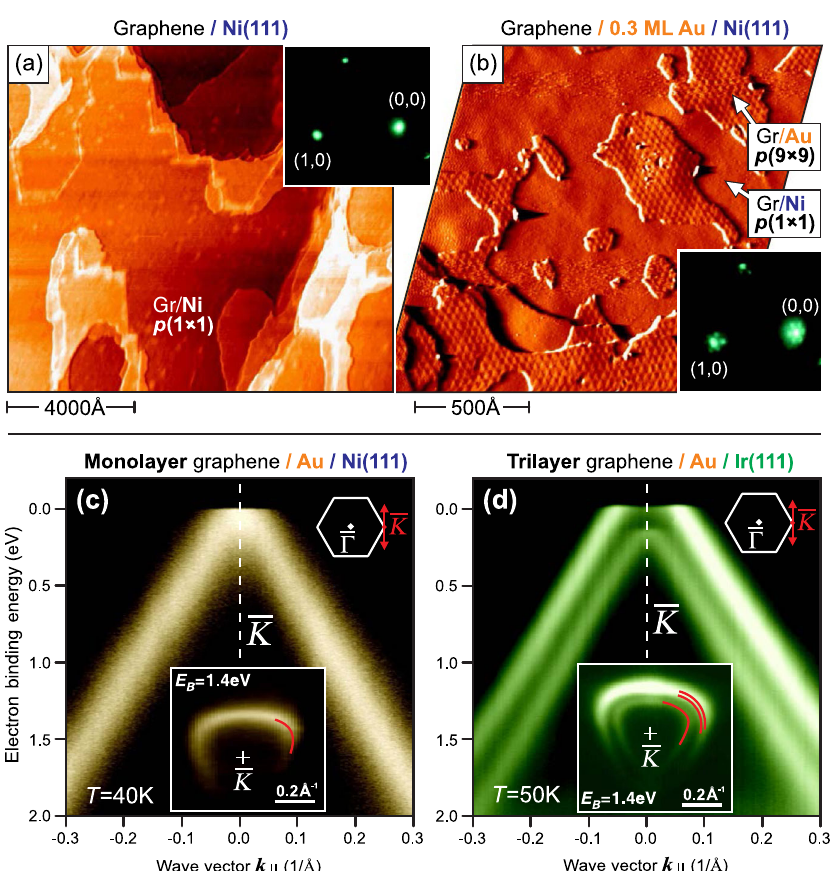
FIG. 5. Absence of graphene superstructure and multilayer formation. (a) Large-scale STM characterization of graphene on Ni(111) showing no moire´ superstructure due to lattice mismatch. (b) The intermediate-scale STM image of graphene on Ni(111) partially intercalated with Au (image contrast is enhanced) reveals a p ð 9 (cid:2) 9 Þ moire´ above Au islands but no moire´ pattern in the graphene on Ni areas. The insets represent LEED images ( E ¼ 40 eV ). (c) The electronic structure of graphene decoupled from Ni(111) by intercalation of Au reveals only one Dirac cone, which means that graphene is a monolayer. (d) Control sample [graphene trilayer on Ir(111)] shows characteristic trilayerlike bands after intercalation of